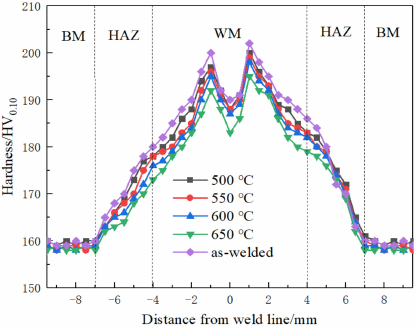
Figure 5. Effect of annealing temperature on microhardness of each area of welding